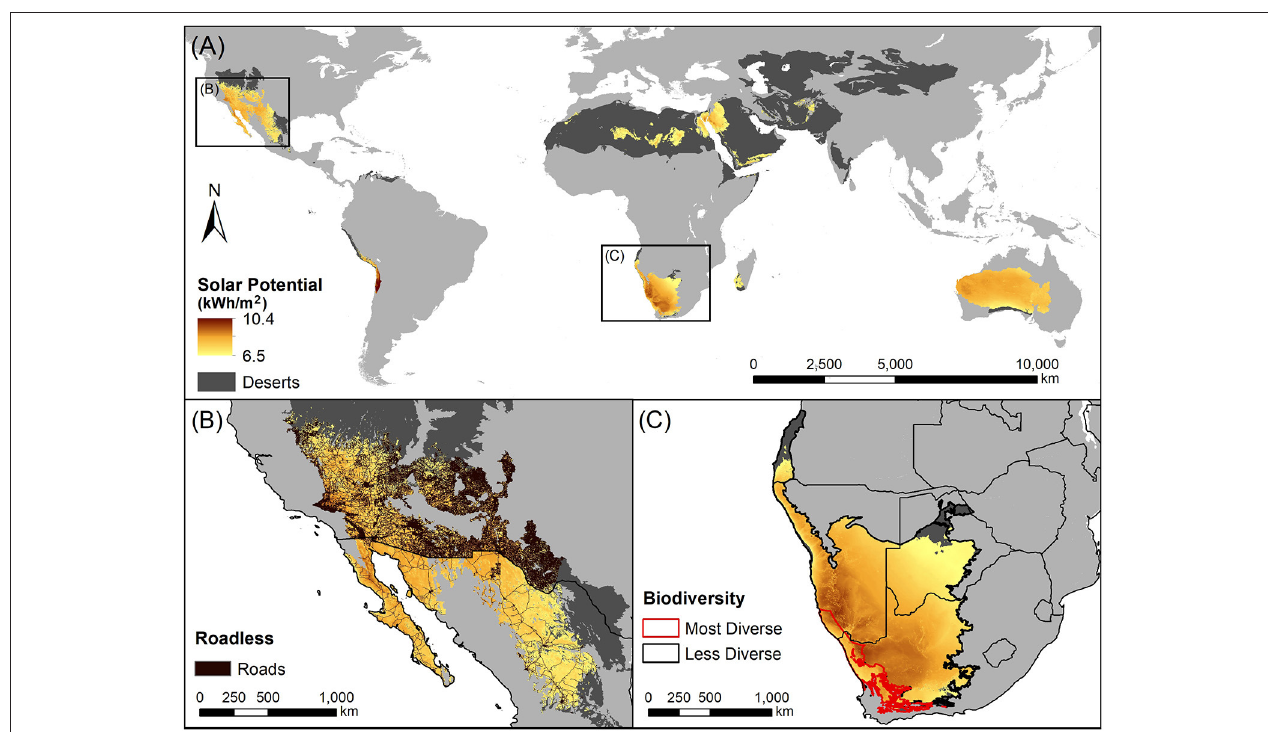
FIGURE 1 | Maps showing (A) the world’s deserts and overlap with economically valuable solar resources, (B) detail for North American deserts, roadless areas, and solar resources, and (C) detail for southern African deserts with economically valuable solar resources and with the highly diverse Karoo ecoregion outlined. Red-yellow shaded areas represent high solar resource levels in all panels and as described in the legend for (A)